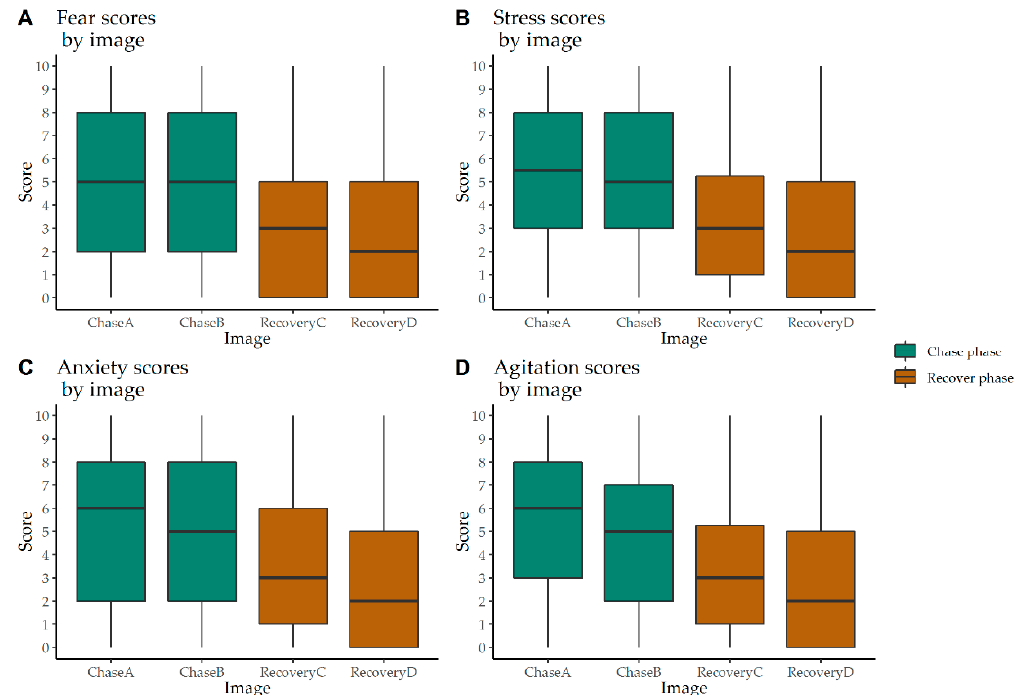
Figure 6. Box and whisker plot of frightened, stressed, anxious and agitated scores applied by a panel of 16 veterinary students on 80 images of calves ( n = 20) showing higher scores in the chase phase compared to the recovery phase of a calf roping event.